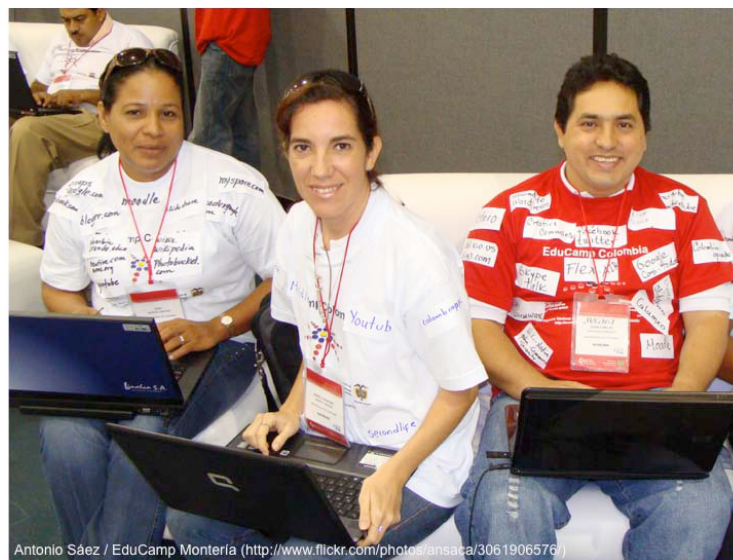
Figure 2 . Participants with tags on their